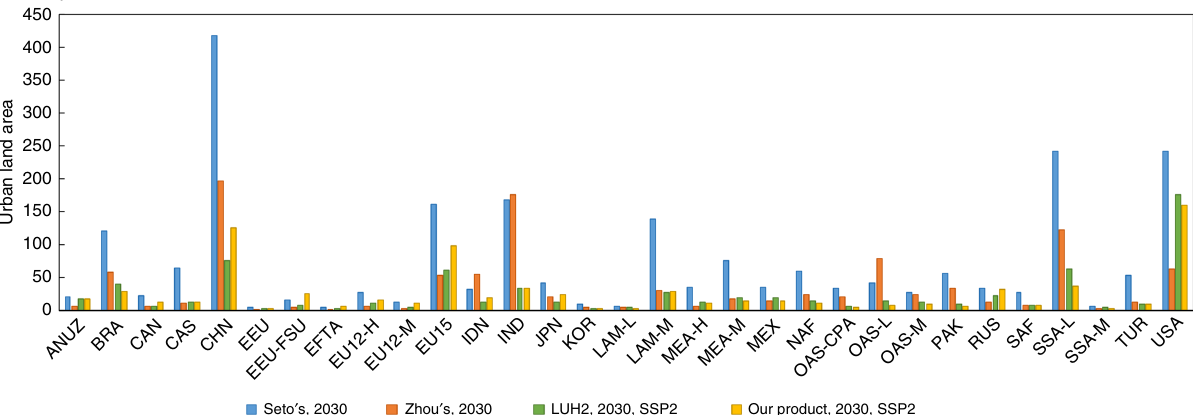
Fig. 5 Comparison of urban land area of 2030 in different regions by Seto ’ s, Zhou ’ s, LUH2 and our model. Our results are signi fi cantly correlated with the three other results. Our results are most consistent with the urban land areas in LUH2 by a signi fi cant Pearson correlation coef fi cient of 0.93. Our results are also signi fi cantly correlated with Seto ’ s and Zhou ’ s by the coef fi cients of 0.82 and 0.56, separately. The abbreviations of the regions are de fi ned following the of fi cial SSP dataset